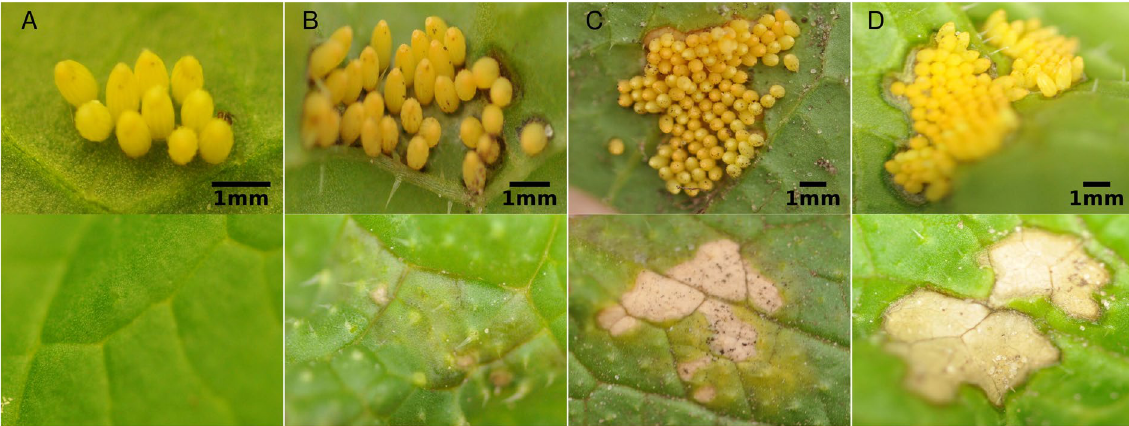
Figure 7. Different severity levels of HR - like necrosis induced by egg clutches of P . brassicae laid onto B . nigra plants under field conditions. The upper row shows the abaxial side of a leaf with eggs, the lower row shows the adaxial side of a leaf. ( A ) No HR - like necrosis induced (no HR = 0), ( B ) HR severity 1: necrosis can be observed below eggs, but hardly on the other side of the leaf, ( C ) HR severity 2: necrosis has spread and can be clearly observed on both sides of the leaf, the edges of the reaction are diffuse. ( D ) HR severity 3: necrosis is strongly expressed also around the egg clutch with sharp edges. All clutches shown are the same age (four days after egg